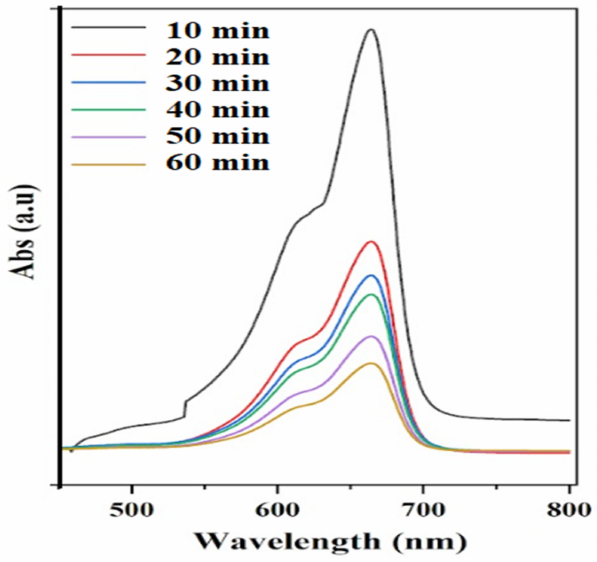
Figure 9. UV-Vis spectra of treated MB solution by photocatalytic degradation using 10% TiO2/SBA-15. The kinetic of methylene blue adsorption on SBA-15 and TiO 2 /SBA-15 was